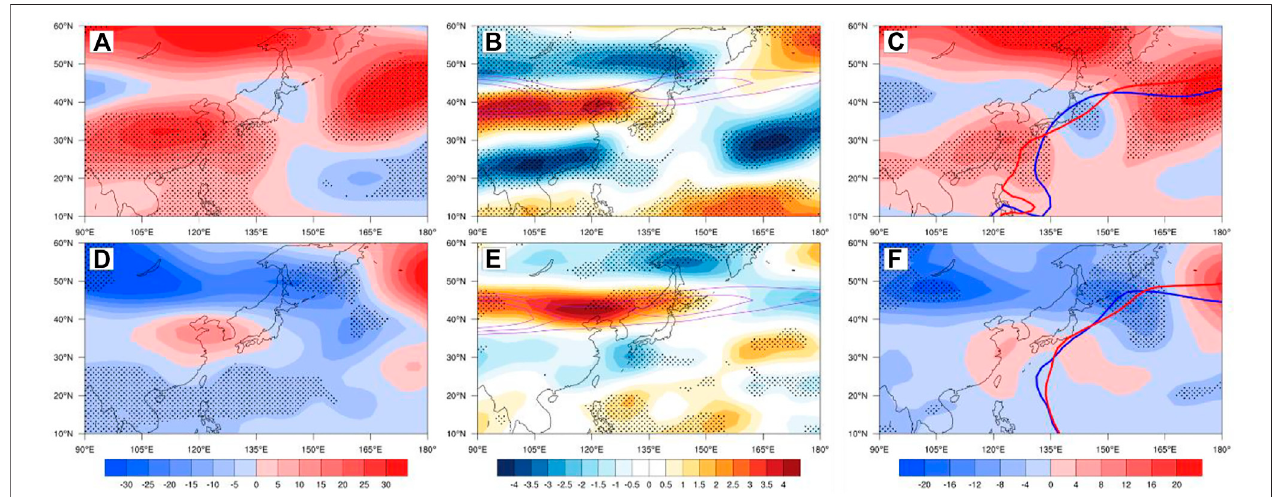
FIGURE 3 | Left column: differences in geopotential height at 200 hPa between the composites of positive and negative years (unit: gpm). Middle column: differences in zonal wind at 200 hPa between the composites of positive and negative years (unit: ms − 1 ). Right column: differences in geopotential height at 500 hPa between the composites of positive and negative years (unit: gpm). [ (A – C) for P1; (D – F) for P2; dotted areas indicate the values are signi fi cant at/above the 95% con fi dence level by Student ’ s t test; red and blue lines in (C) and (F) represent composites of 0 gpm contour of eddy geopotential height for positive and negative years, respectively; purple contours in (B) and (D) represent climatological zonal wind at 200 hPa, in which contour values are 25, 27.5, and 30, respectively.]